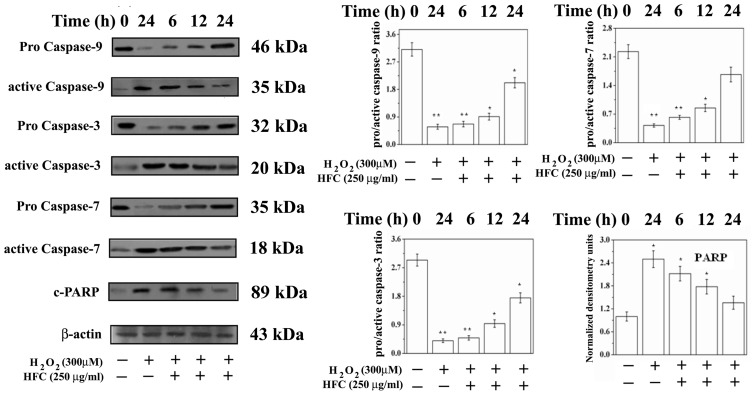
Polysaccharide imposed protection against H2O2-induced intrinsic apoptosis of WI38 cells via caspase inhibition at protein level.WI38 cells were incubated in presence (250 µg/mL) or in absence of HFC polysaccharide for 1 h followed by the treatment with 300 µM H2O2 in both the cases for varying periods of time (0–24 h). Protein level expression of various pro- and active forms of caspases (caspase-9, -3, and -7) and cleaved PARP was evaluated by immunoblotting. β-actin was used as loading control. Band densitometries are represented as a ratio between pro and active caspases in the form of bar graphs, Results are representative of three independent experiments performed in triplicate and are represented as mean ± SD. A one-way analysis of variance (ANOVA, Bonferroni corrections for multiple comparisons) was performed, where significant level stands for * p<0.05, ** p<0.001.